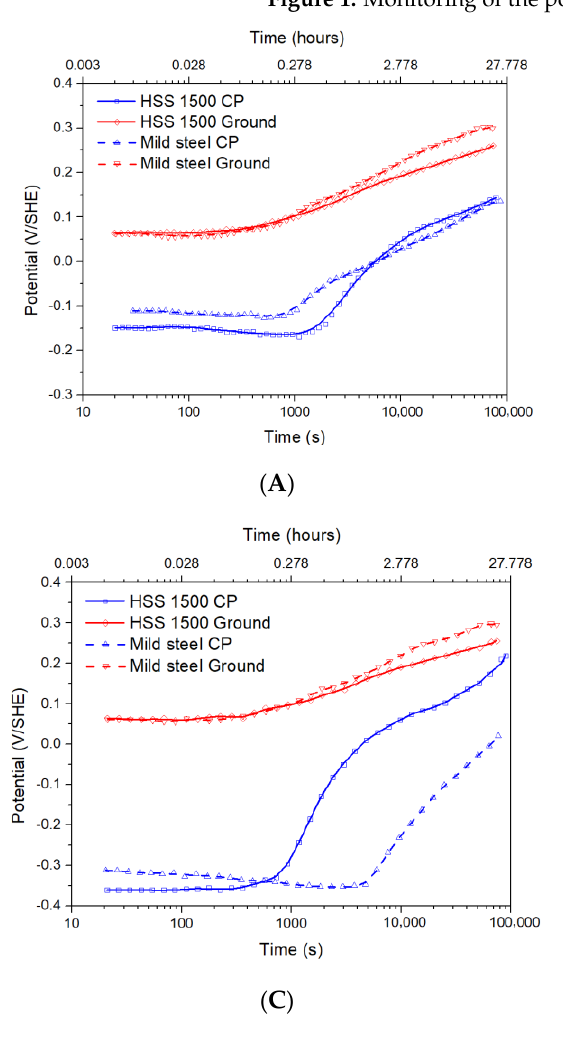
Figure 2. Potential monitoring of the steel after surface grinding (mild steel ground and HSS 1500 ground) and after grinding followed by cathodic treatment in 0.1M NaOH aqueous electrolyte (HSS 1500 CP and mild steel CP) with a current density of − 5 mA/cm 2 for 2.22h ( A ), − 5 mA/cm 2 for 4.44 h ( B ) and − 25 mA/cm 2 for 24 h ( C ). 4.44 h ( B ) and − 25 mA/cm 2 for 24 h ( C